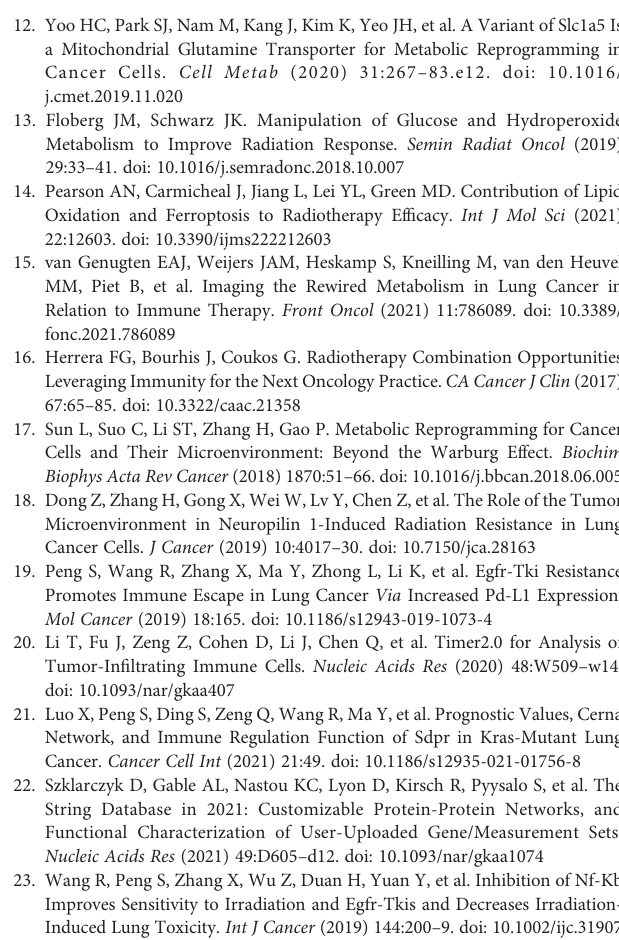
Supplementary Figure 1 | The construction of a protein-protein interaction (PPI) network. DEGs between radio-resistant (A549RR) and parent (A549) cells were analyzed to evaluate PPI using the STRING database. Molecules and connections were mapped as nodes and lines. Proteins with high combined scores (> 0.9) and high co-expression coef fi cient (> 0.9) were screened out and mapped. Supplementary Figure 2 | Validation of metabolic-based prognostic models in lung adenocarcinoma (LUAD) patients received radiation therapy. (A). Metabolism Score and overall survival status of LUAD patients received radiation therapy using metabolic prognostic model and Kaplan – Meier plotter analysis. (B). Prediction and observed of ROC curve based on Metabolism Score. Supplementary Figure 3 | Expression of DTYMK, GCDH, HEMK1 in A549 and A549RR cells measured by RT-qPCR. **p < 0.01. Supplementary Figure 4 | Percentages of immune subtypes in LUAD with low and high Metabolism Score calculated by ssGSEA algorithm. Immune subtypes with signi fi cant difference between low and high Metabolism Score groups were marked. **p < 0.01 and ***p <